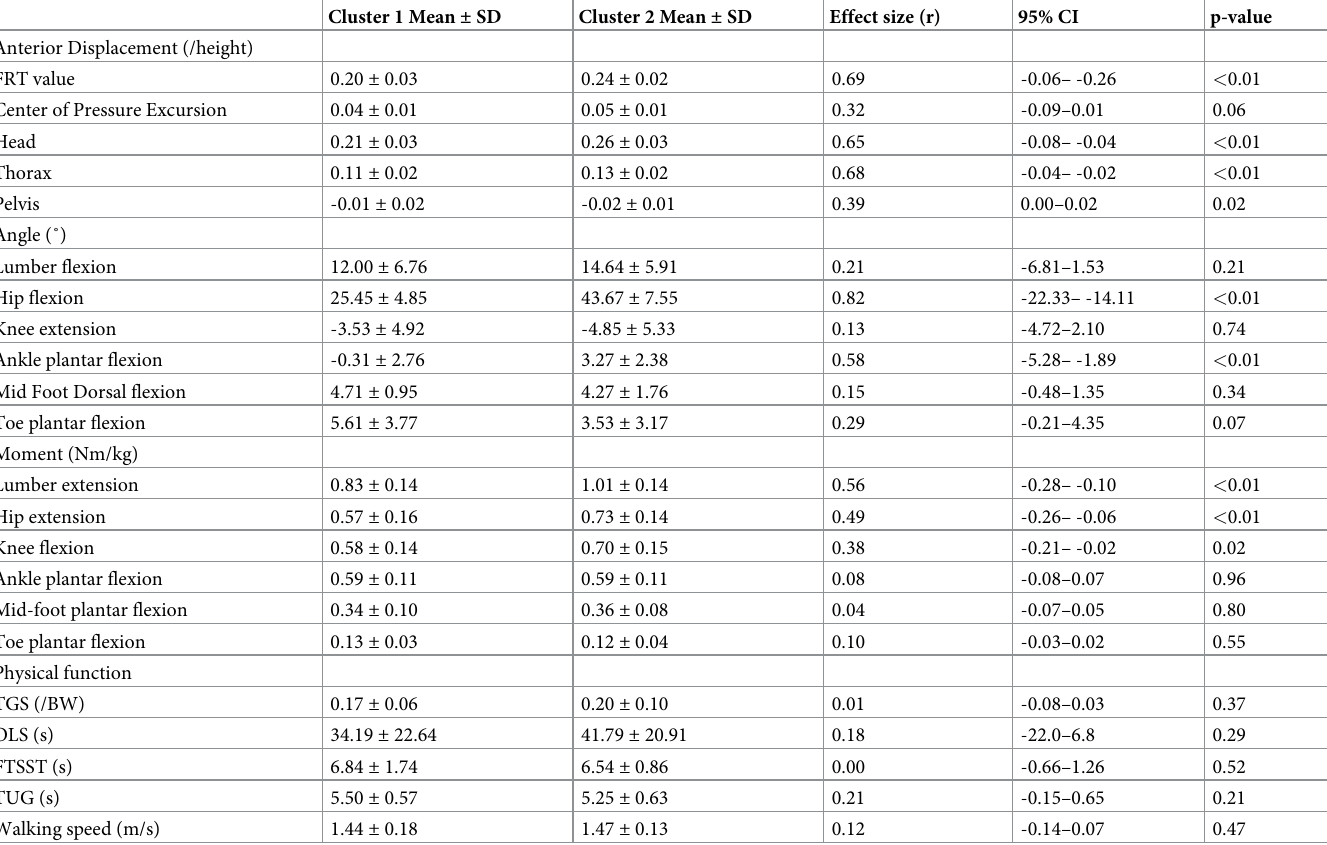
Table 2. Comparison of Cluster 1 and Cluster 2 in older